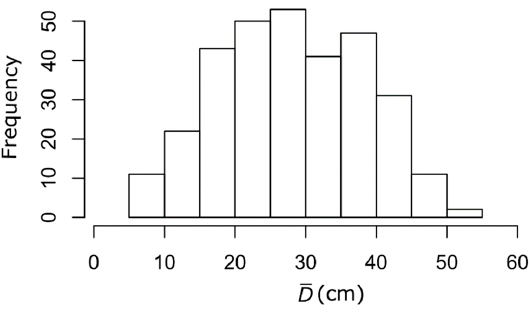
Figure 2. Mean tree-stump diameter distribution for the tree-stumps measured in the field.